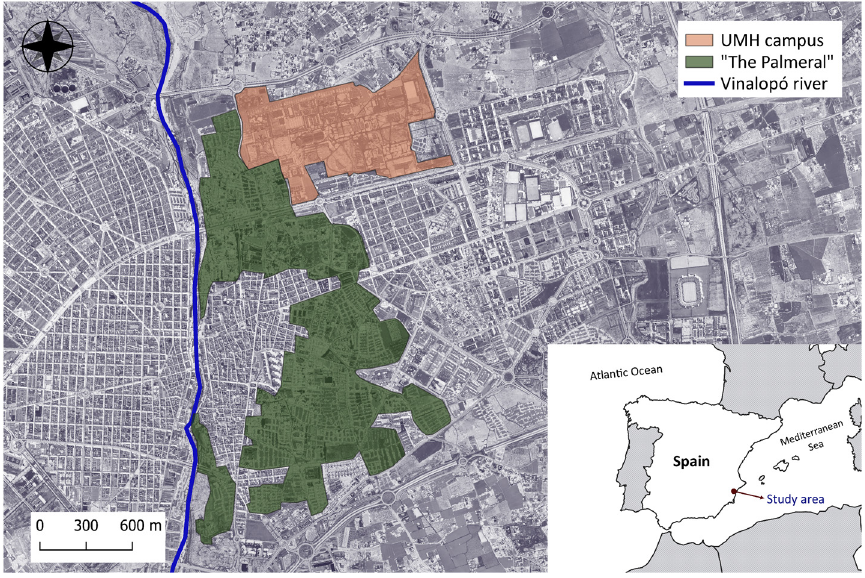
Figure 1. Study area location.